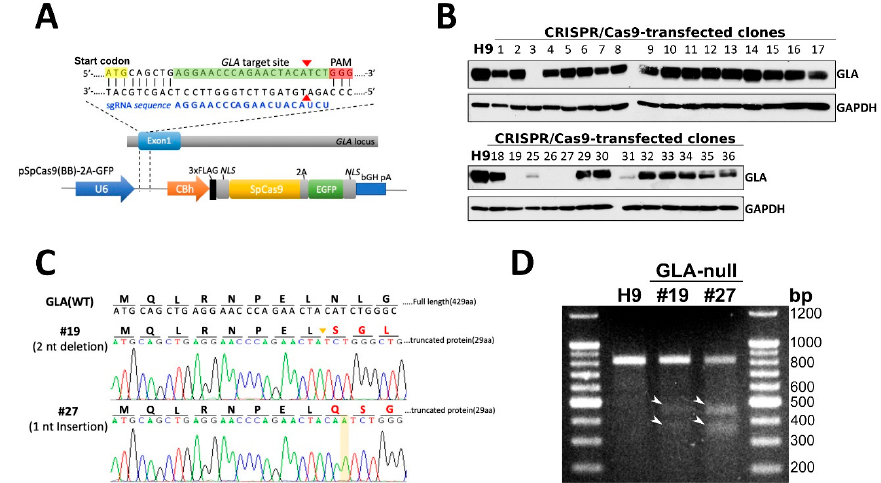
Figure 1. CRISPR/Cas9-mediated knockout of expression of GLA in hESCs. ( A ) Schematic depiction of sgRNA-guided Cas9 target site within exon 1 of GLA gene. The sgRNA sequence (5 ′ -AGGAACCCAGAACUACAUCU-3 ′ ) is labeled in blue font and PAM recognition sequence highlighted in red. The gRNA targeting site in the GLA exon 1 region is highlighted in green and the double-strand breaking site is indicated by the red arrowheads. The start codon is highlighted in yellow. ( B ) Western blot screening of 30 CRISPR/Cas9-corrected clones for expression of GLA protein. H9 cells were used as wild type parental control. GAPDH used as a loading control. ( C ) Sanger sequencing analysis confirming two nucleotides deletion and one nucleotide insertion in CRSIPR/Cas9-edited hESC clones #19 and #27, respectively. ( D ) T7E1 digestion assay of the mutants at the target site in GLA gene. The mismatch T7E1 cleavage products are marked with white arrowheads.